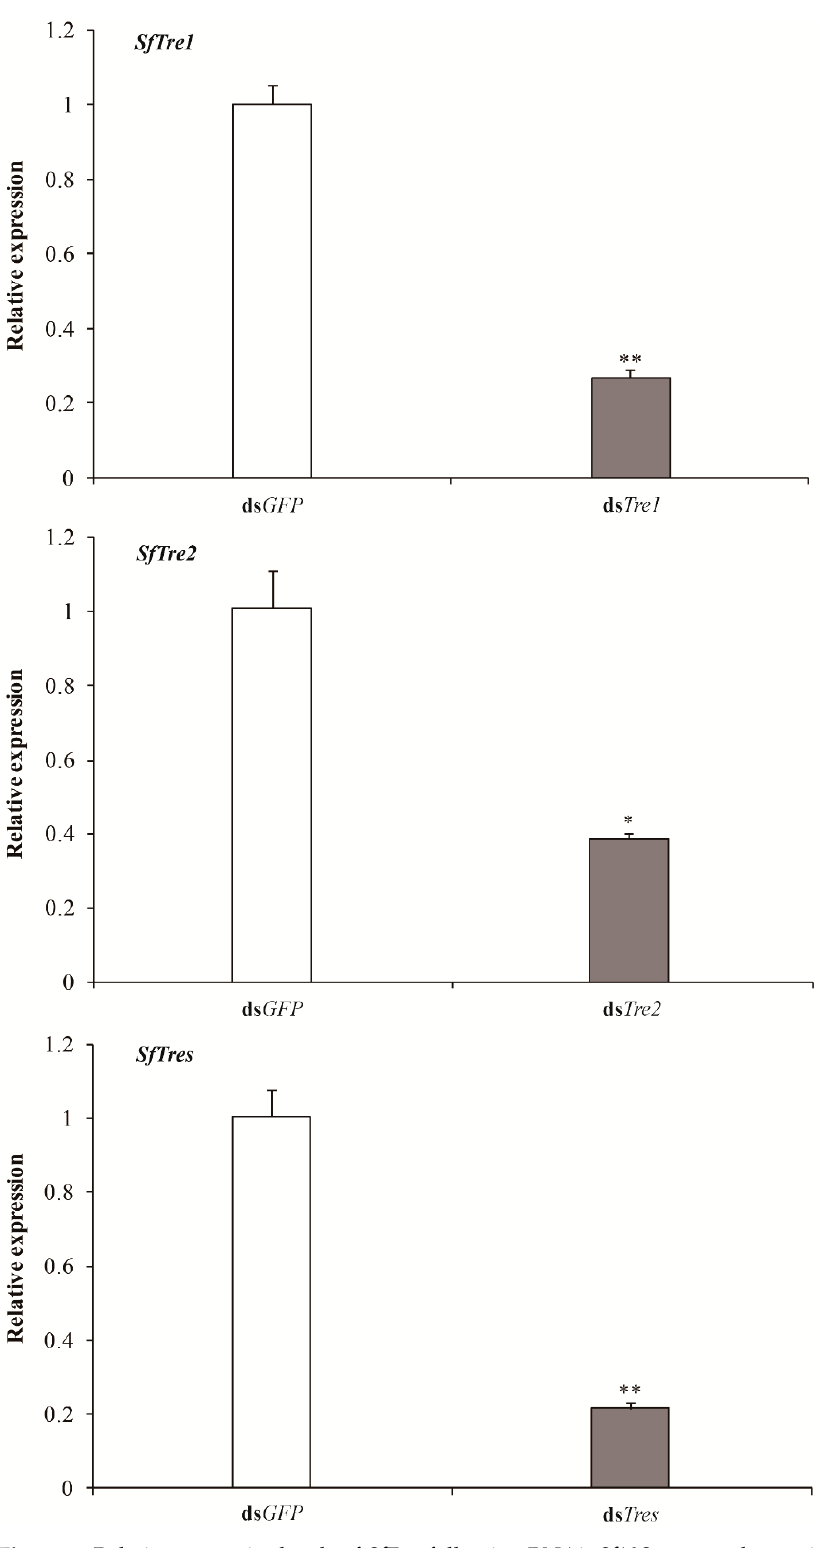
Figure 6. Relative transcript levels of SfTre s following RNAi. Sf18S was used as an internal reference gene. Data are presented as means ± standard error of three biological replicates. * indicates significant differences at the p- value of < 0.05 by independent sample t -test. ** indicates highly significant differences at the p -value of < 0.01. SfTres , SfTre1 + SfTre2 ; ds Tres , ds Tre1 + ds Tre2 .